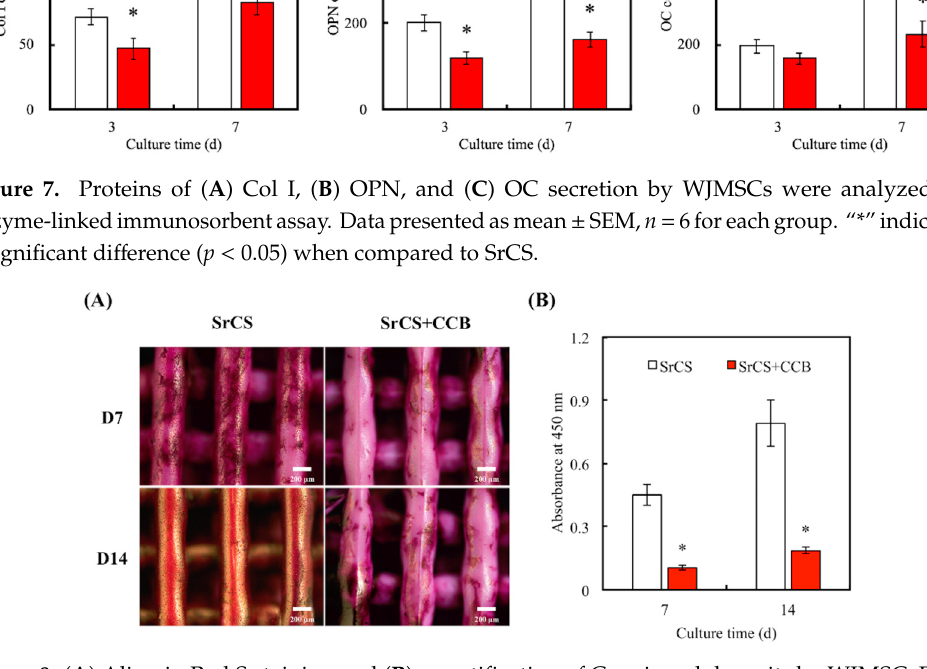
Figure 8. ( A ) Alizarin Red S staining and ( B ) quantification of Ca mineral deposits by WJMSC. Data presented as mean ± SEM, n = 3 for each group. “*” indicates a significant difference ( p < 0.05) when compared to SrCS.